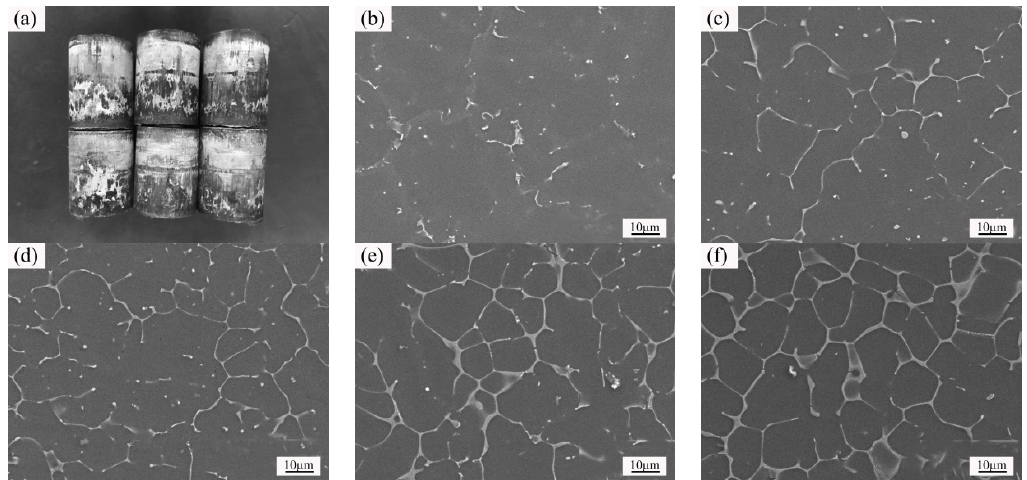
Figure 5. The image and SEM microstructure of the liquid forging parts with different Y-element